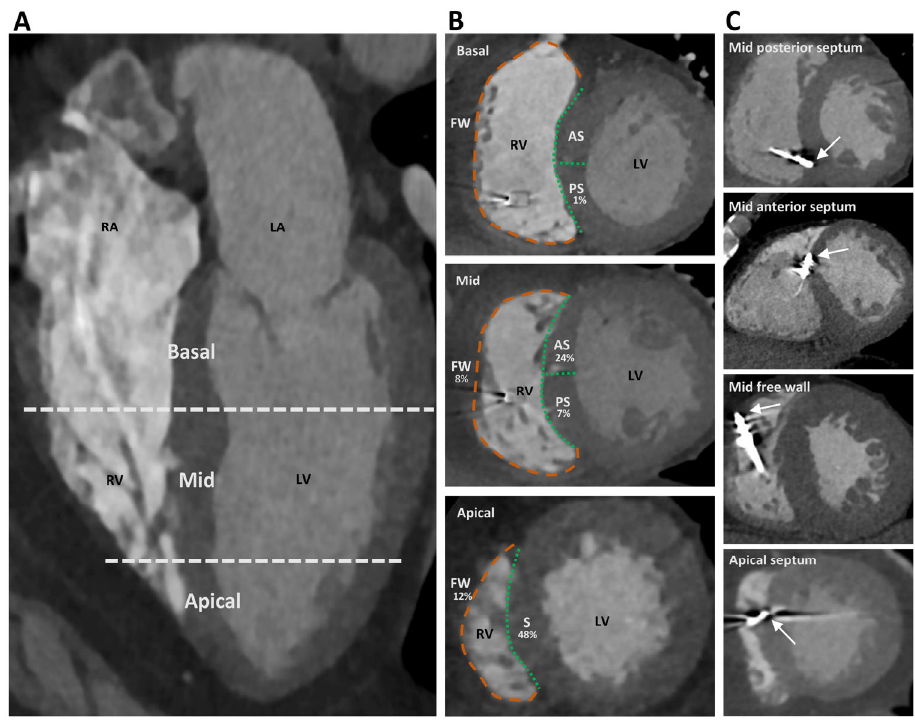
Figure 1. Assessment of right ventricular (RV) lead position. Panel ( A ): A simplistic approach was used dividing the left ventricular (LV) long axis into equal thirds (basal, mid, and apical). Panel ( B ): Septal (S) (green dashed lines) or free wall (FW) (orange dashed lines) positions were then analyzed in short axis view. For primary outcome analysis, the RV lead position was categorized into septal (mid and basal septum) and non ‐ septal (apical septum or free wall). Mid and basal septum were further divided into anterior septum (AS) and posterior septum (PS). The distribution of RV lead positions is shown for each segment. Panel ( C ): Examples of different RV lead tip positions (white arrows). LA, left atrium; RA, right atrium.